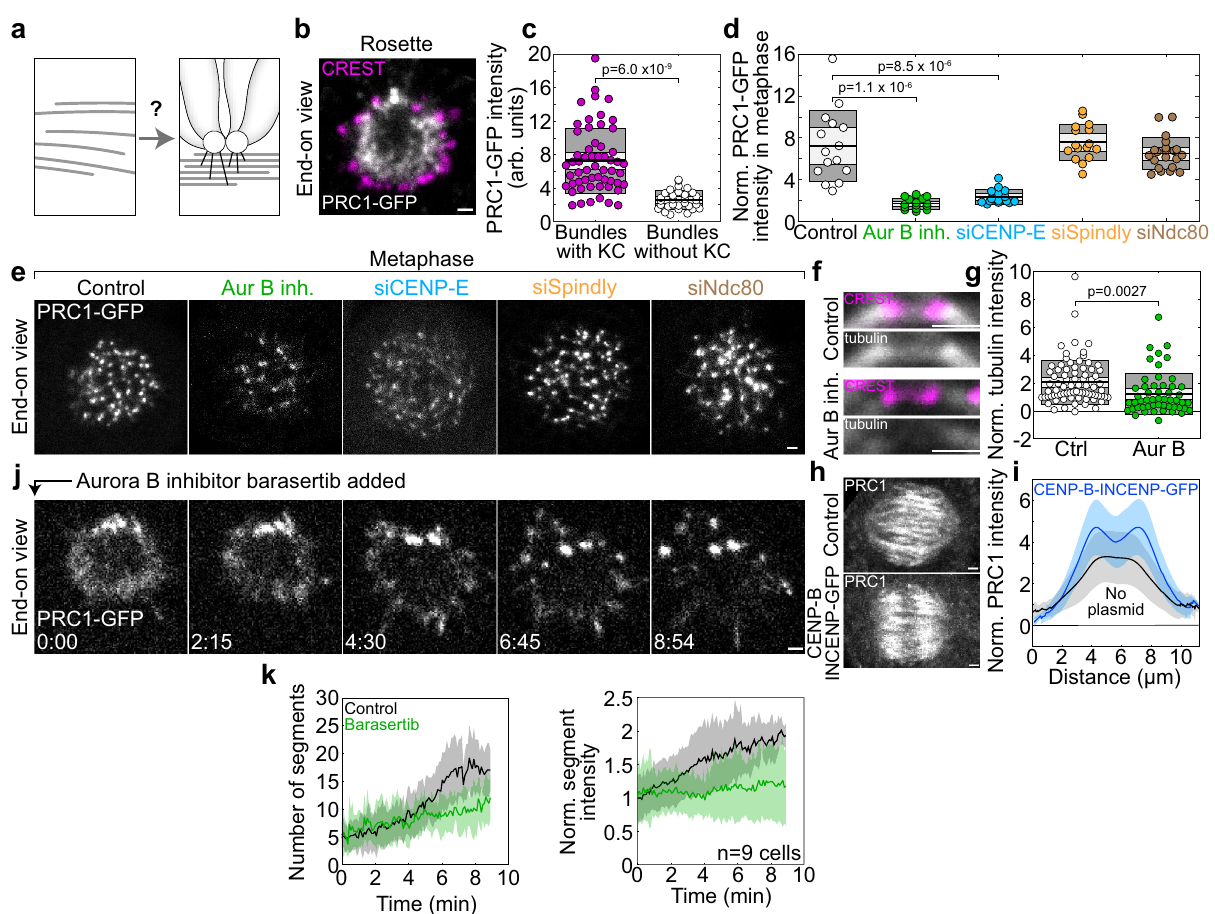
Fig. 2 | Kinetochores promote microtubule bundle formation in an Aurora B-dependent manner. a Scheme of kinetochore-driven bundle formation. b Midplane of a vertical spindle immunostained for CREST (magenta) in a HeLa- Kyoto cell expressing PRC1-GFP (white). c PRC1-GFP intensity of bundles with and without adjacent kinetochore, n =57 and 30 bundles, respectively. d PRC1-GFP intensity ofbundles in vertical metaphasespindles (circlesrepresent the mean per spindle), normalized to the cytoplasmic PRC1-GFP intensity. Numbers of bundles/ cellsfromlefttoright:827/15,452/14, 730/15,880/16,774/21; p valuesare givenfor thesigni fi cantdifferencesfromcontrol,one-wayANOVAtest. e Verticalmetaphase spindles in HeLa-Kyoto cells expressing PRC1-GFP (white), treated as indicated. f Region around a kinetochore pair immunostained for CREST (magenta) and tubulin (white) in an untransfected HeLa cell, control (top) and after Aurora B inhibition(bottom), merged channelsandonlytubulin. g Meantubulinintensityat the bridging fi ber center in control and AuroraB-inhibited cells, normalized to the cytoplasmatic anti-tubulin intensity; n =78/10 bundles/cells (control) and 52/9 (inhibition). h Maximum-intensity projections of metaphase spindles